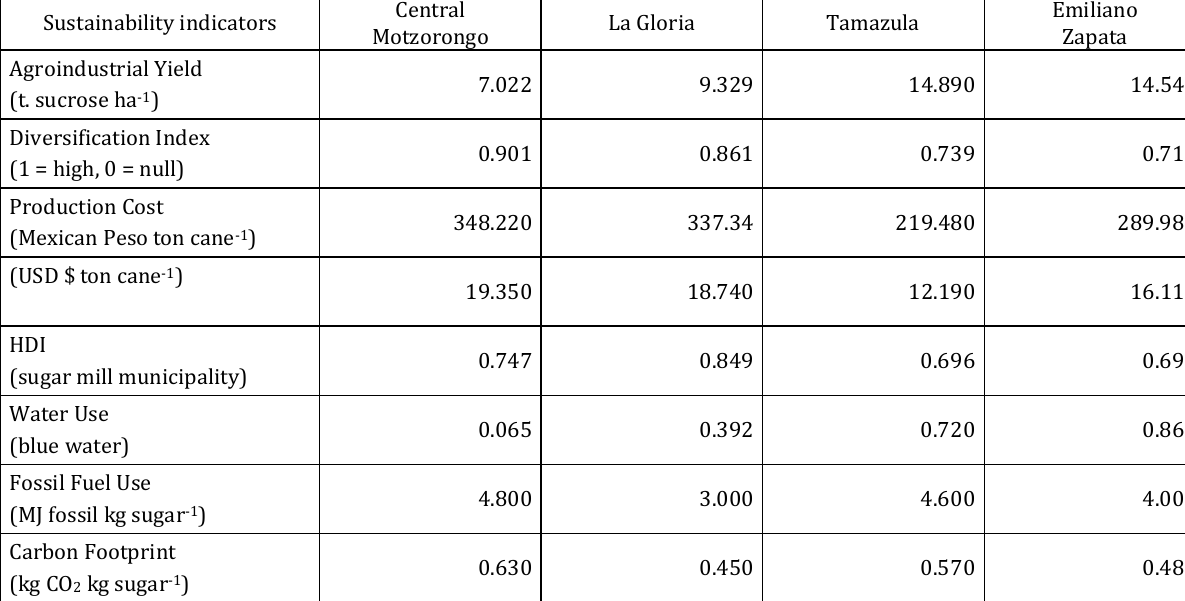
Table 3. Results of sustainability